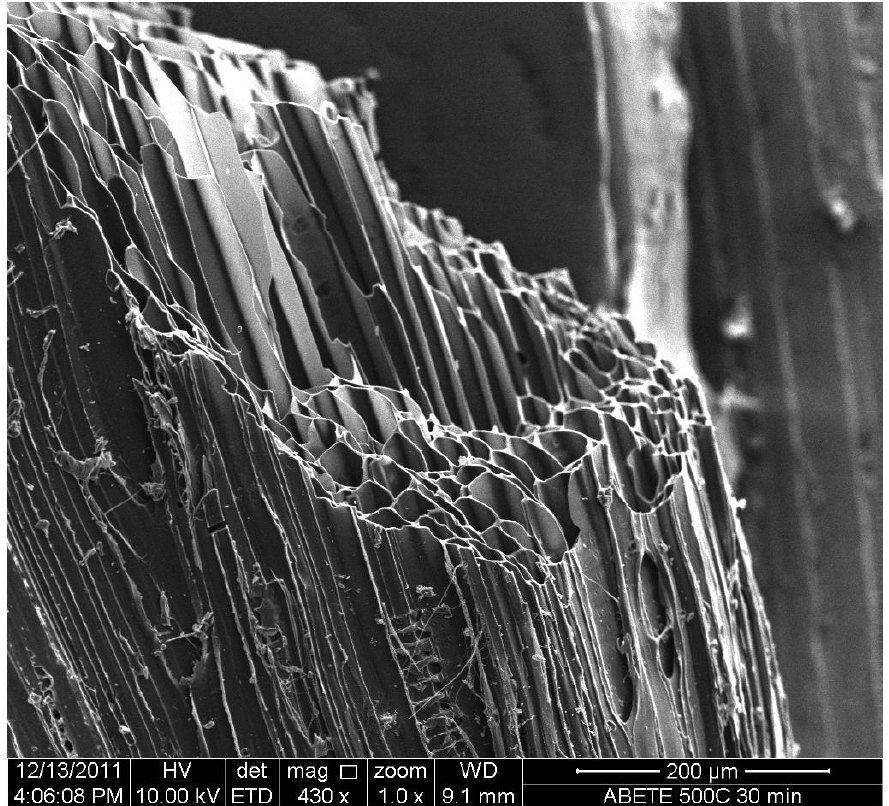
Figure 4. Photo acquired by a scanning electron microscope (SEM) of a biochar from fir biomass charred at 500 ◦ C for a period of 30 min via the lab–muffle–furnace method (Appendix A). The honeycomb-like group of pores, due to the cellular structure of the feedstock, are clearly visible (unpublished results from the group of